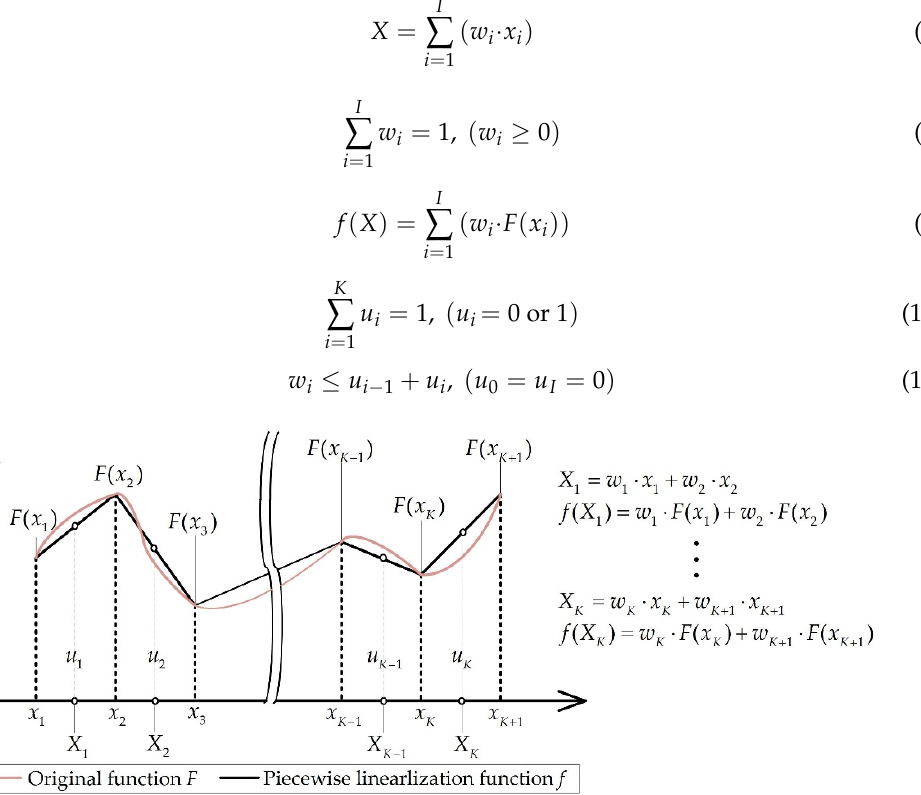
Figure 1. Example of SOS2 application to function F .